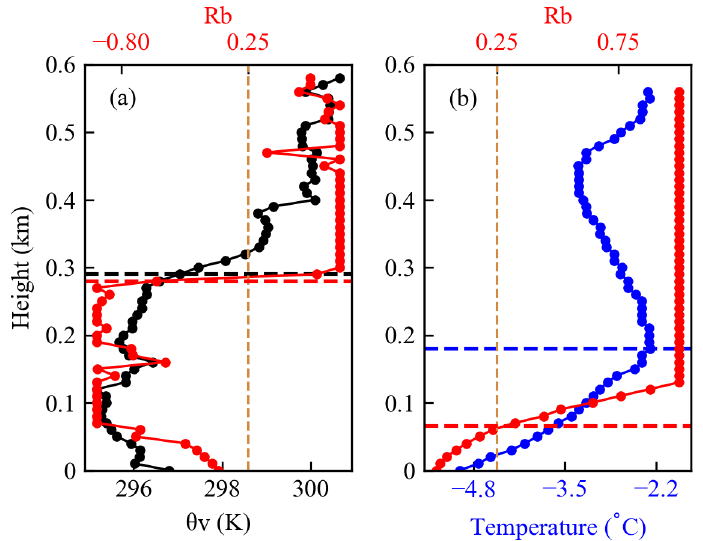
Figure 2. BLHs determined (horizontal lines) from ( a ) bulk Richardson number (Rb) and Holzworth method at 14:00 (Beijing time) and ( b ) bulk Richardson number (Rb) and temperature inversion method at 02:00 (Beijing time) on 23 December 2019. The values of Rb > 1.0 were set to 1.0 in Figure 2 for better presentation.